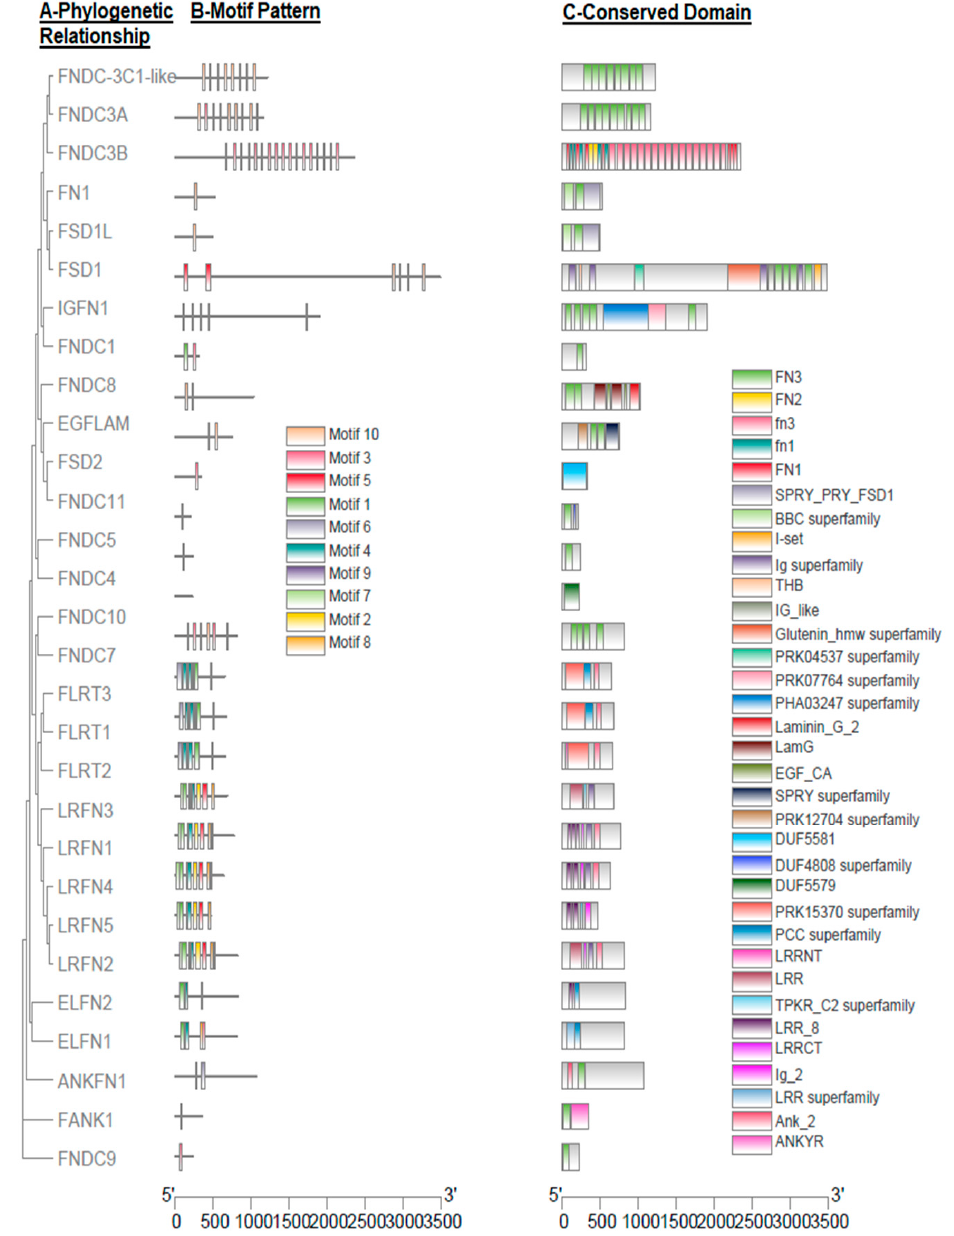
Figure 1. Phylogenetic relationships, motif patterns, and conserved domain regions of buffalo FN-III proteins. ( A ) Phylogenetic relationship of 29 amino acid sequences of FN-III proteins. ( B ) Motif pattern. ( C ) Conserved domain regions. Buffalo ten putative motifs of FN-III proteins are indicated in different colored boxes and details of motifs are enlisted in Table 2.